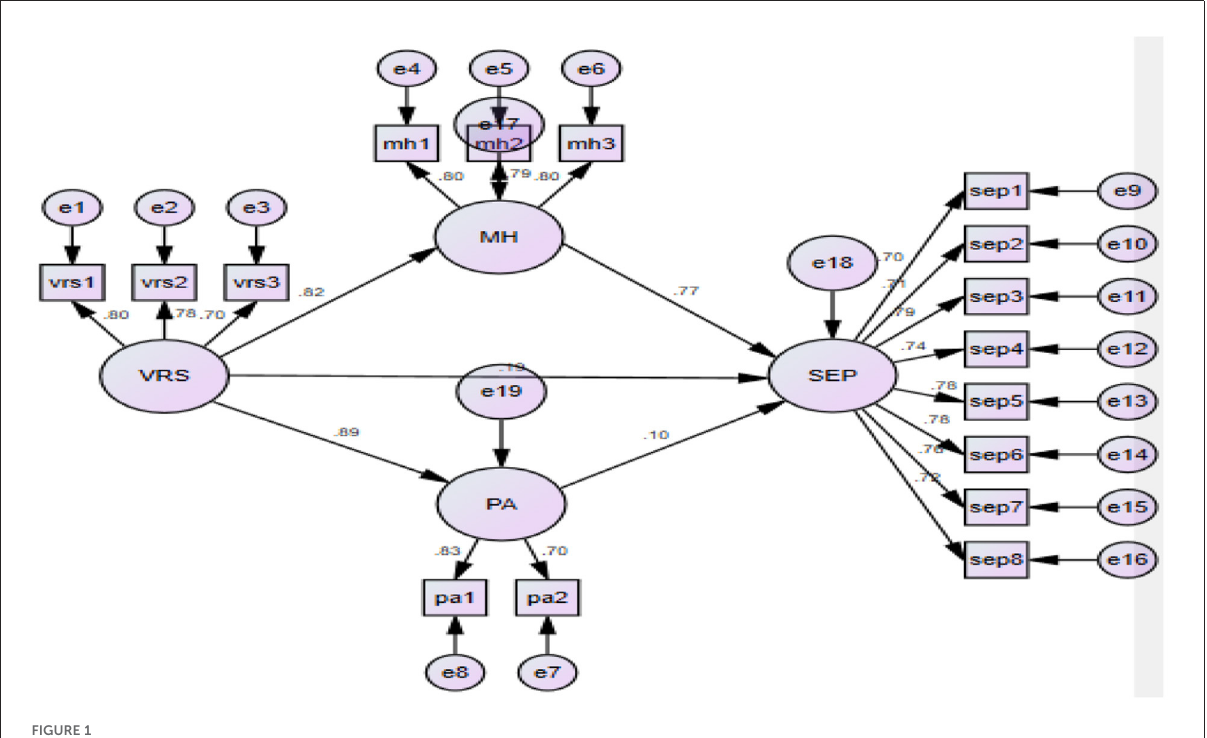
FIGURE1 Structural model.